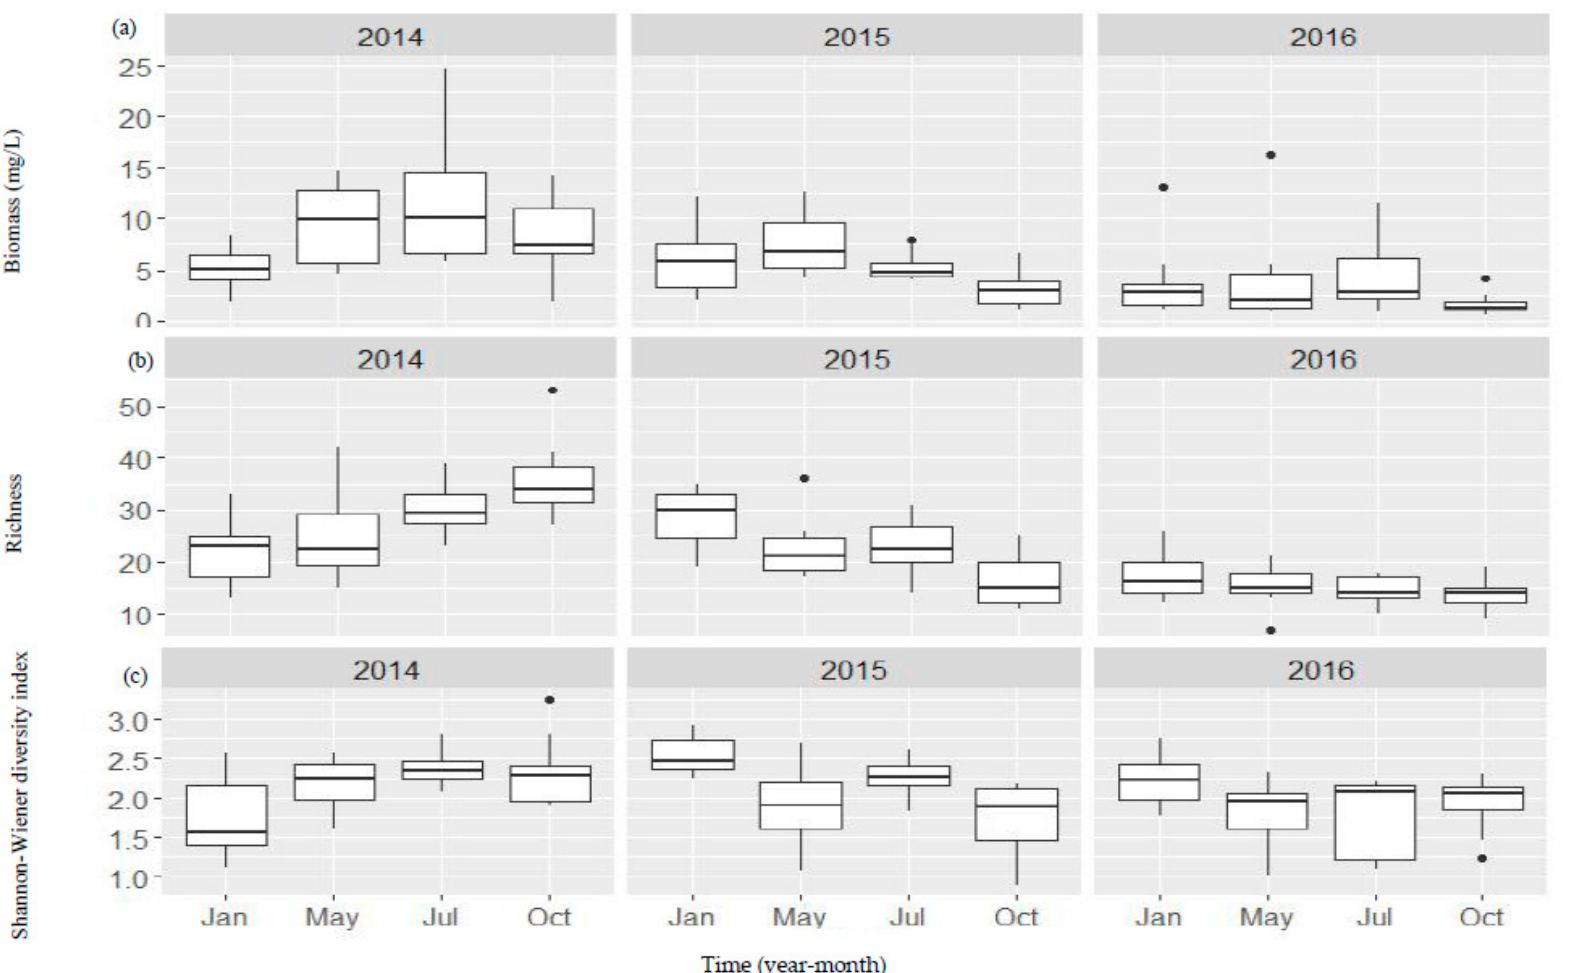
Figure A2. Boxplots showing both temporal and spatial variation of biomass ( a ), richness ( b ), and Shannon–Wiener diversity index ( c ) of phytoplankton assemblages between 2014 and 2016 in the Danjiangkou Reservoir.